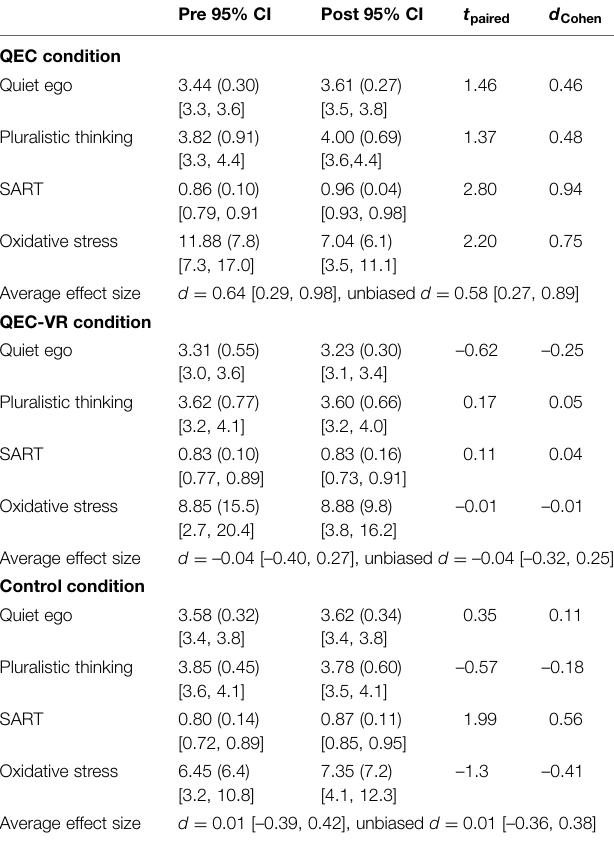
TABLE 4 | Pre–post changes on outcome variables: paired t -tests, effect sizes, and 95%